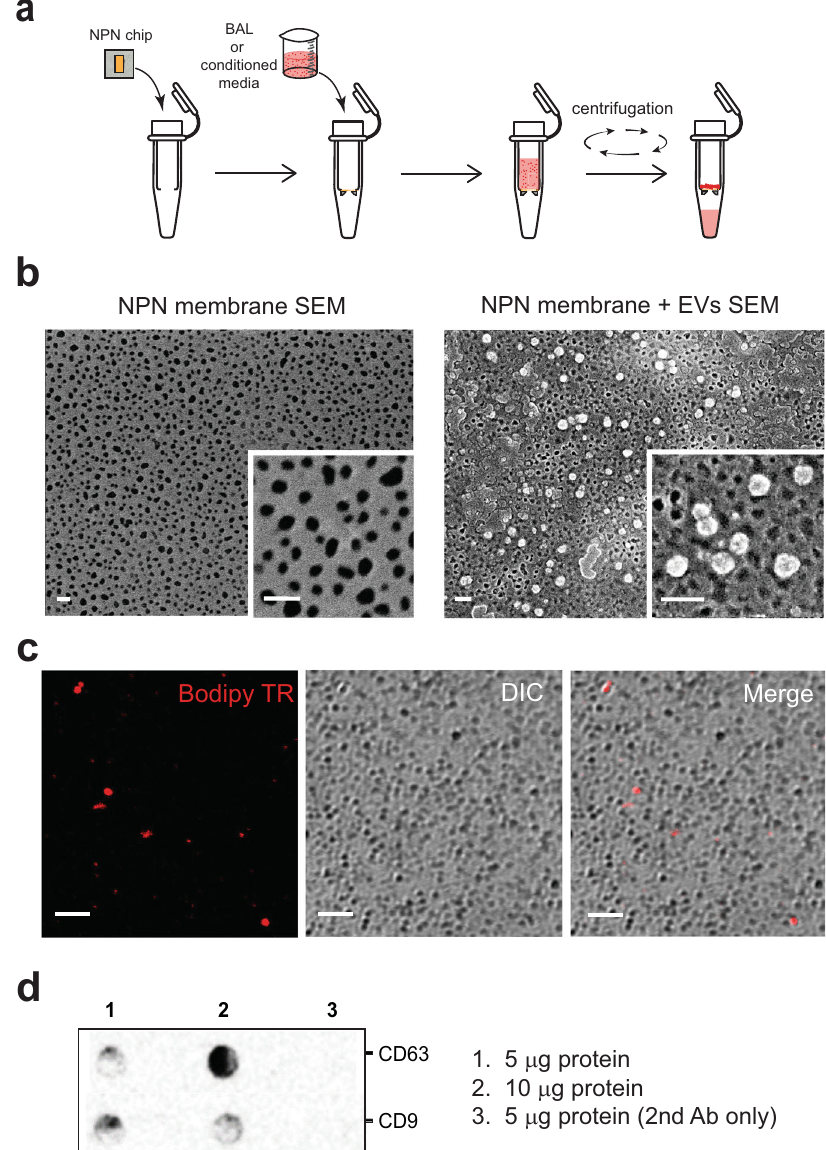
Fig. 1 Capture and characterization of EVs on NPN membranes. a Steps involved in the capture of EVs from the pre-cleared BAL or cell-conditioned media, using SepCon ™ centrifuge tubes with a plasma-cleaned NPN chip insert. The insert consists of an ultrathin nanoporous NPN membrane and silicone support. b SEM images showing the nanoporous membrane, before (left) and after (right) fi ltration of EV-rich fl uids (scale bar 200 nm). c Laser confocal microscopic images of NPN membrane-captured particles stained with the lipid dye, Bodipy-Texas Red (Bodipy TR) in Differential Interference Contrast (DIC) mode and merged image of two channels (Merge). Scale bar 5 µ m. d A dot blot analysis of NPN-captured vesicles veri fi es the expression of CD9 and CD63 tetraspanin